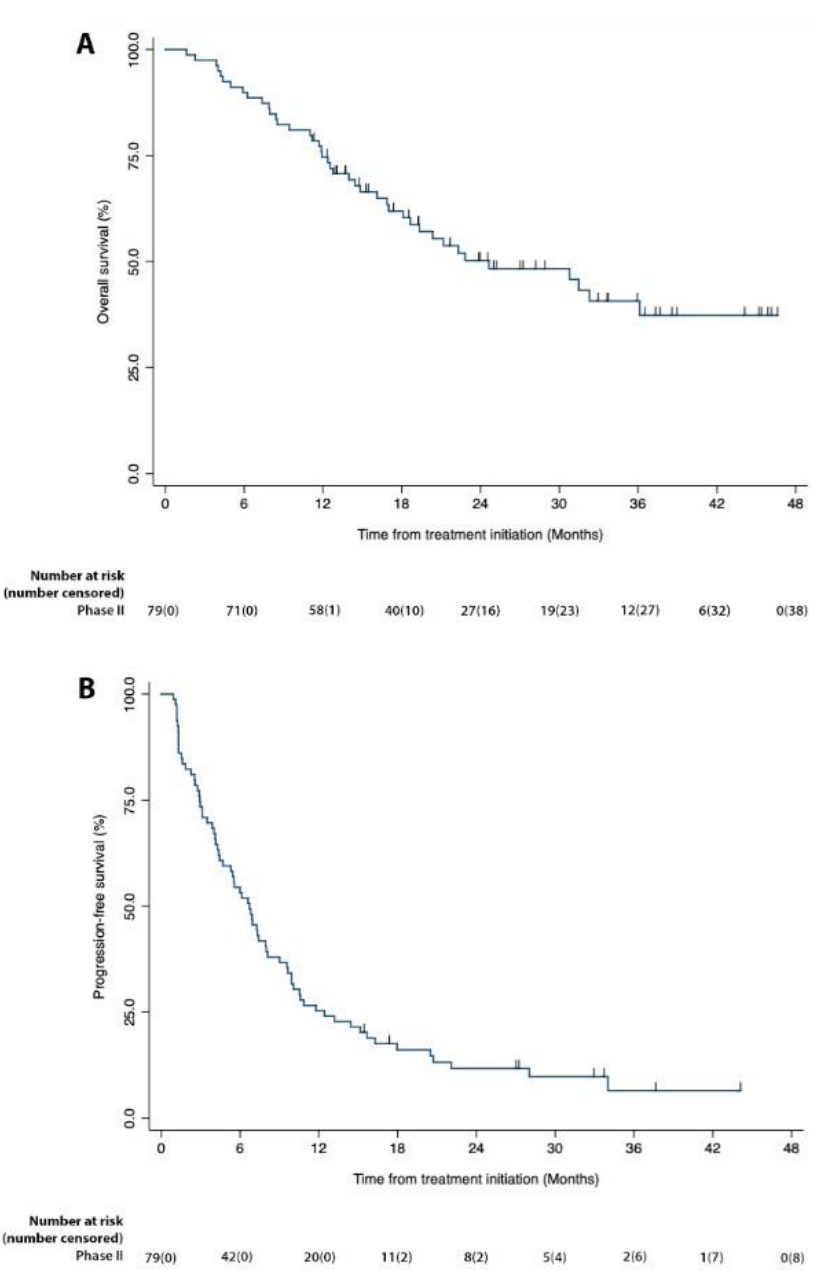
8 of 12 Table 3. Expanded Phase II: Responses to treatment for the mITT population ( n = 79). Best Response